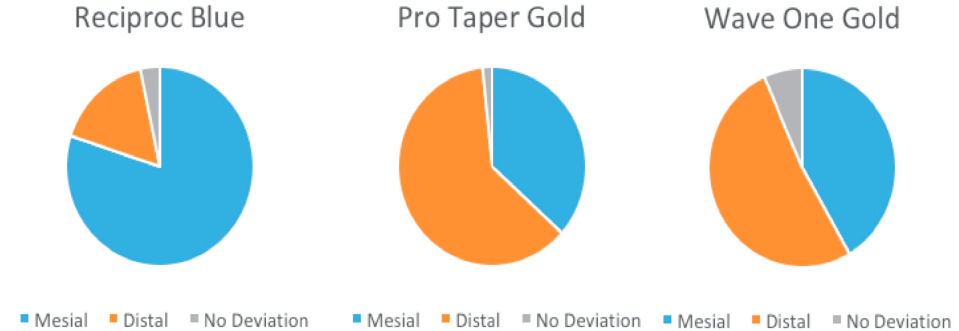
Figure 4. Direction of bucco-lingual transportation for Reciproc Blue, ProTaper Gold, and WaveOne Gold.